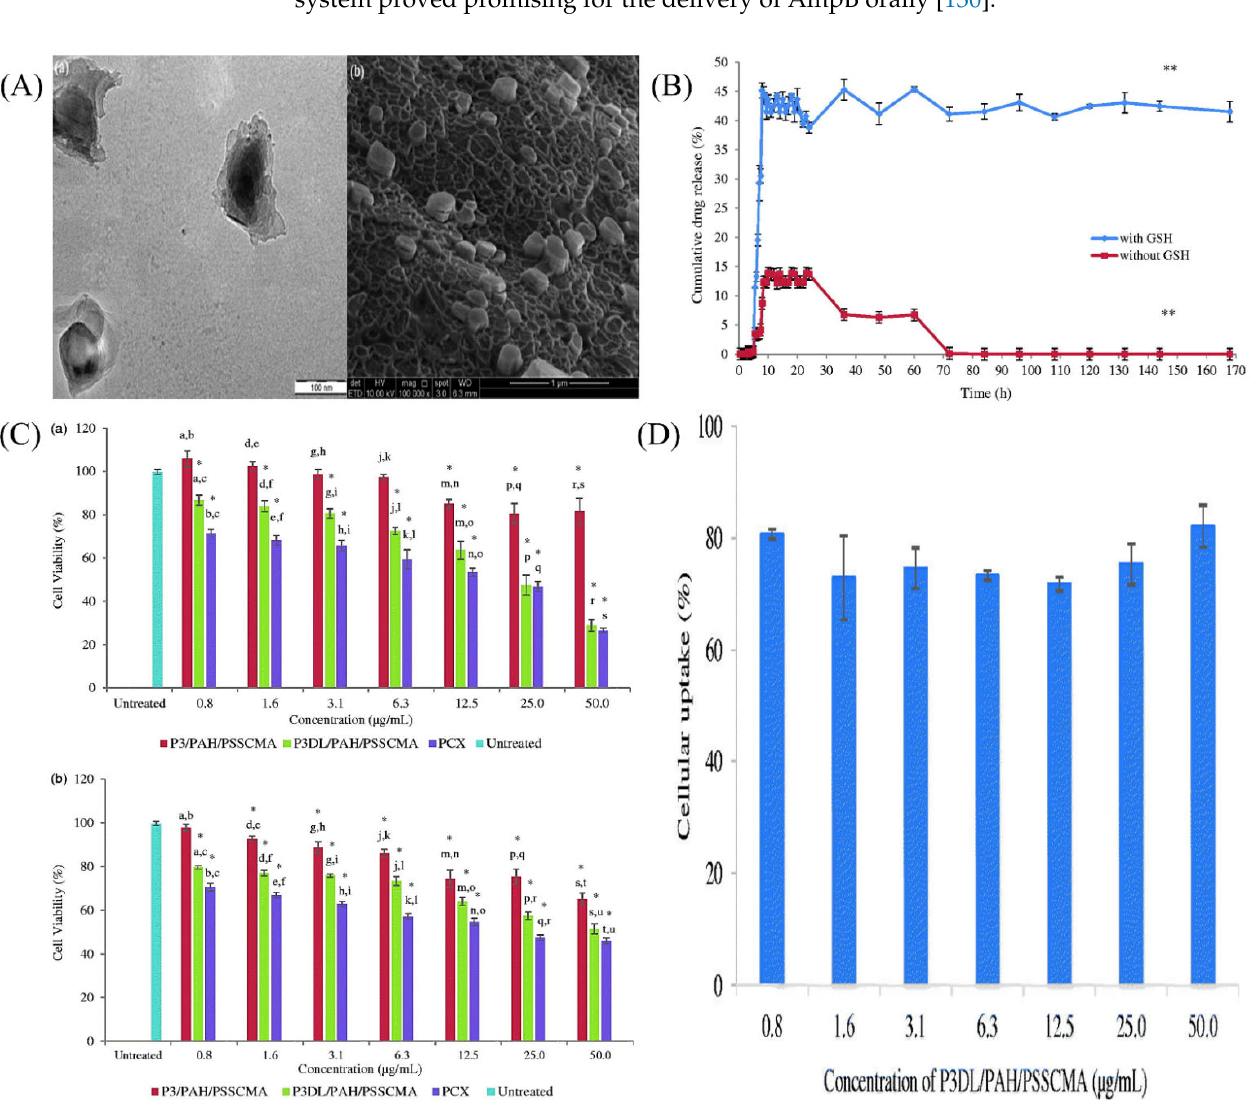
Figure 6. Biocompatible disulfide cross-linked SA derivative nanoparticles for oral colon-targeted drug delivery ( A ) P3DL/PAH/PSSCMA (a) TEM and (b) FeSEM pictures at magnifications of 110,000 and 100,000, respectively. ( B ) For 170 h in a simulated gastrointestinal medium, the cumulative % drug release of P3DL/PAH/PSSCMA was measured. ** means p < 0.01. ( C ) The effects of P3/PAH/PSSCMA, P3DL/PAH/PSSCMA, PCX and untreated P3/PAH/PSSCMA on (a) HT-29 and (b) CRL 1790. Data marked with the same letters show significant difference between the samples. * Indicates p < 0.05 compared to the untreated samples. ( D ) P3DL/PAH/PSSCMA nanospheres tagged with rhodamine 110 are taken up by HT-29 cells. Reproduced with permission from [126], copyright Taylor & Francis Online, 2019.